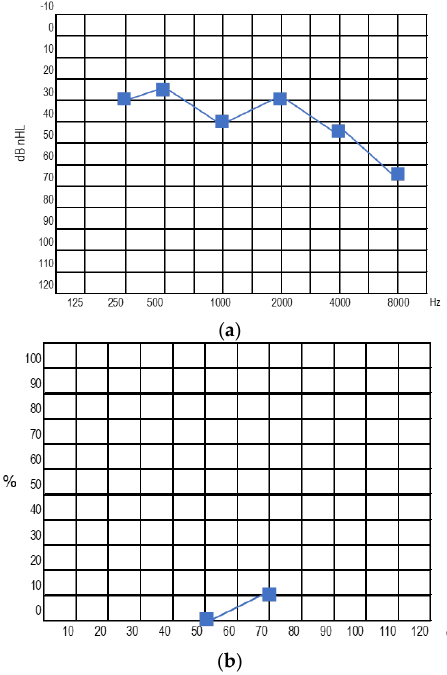
Figure 6. Pure tone audiometry ( a ) and speech audiometry ( b ) at last visit with left cochlear implant.